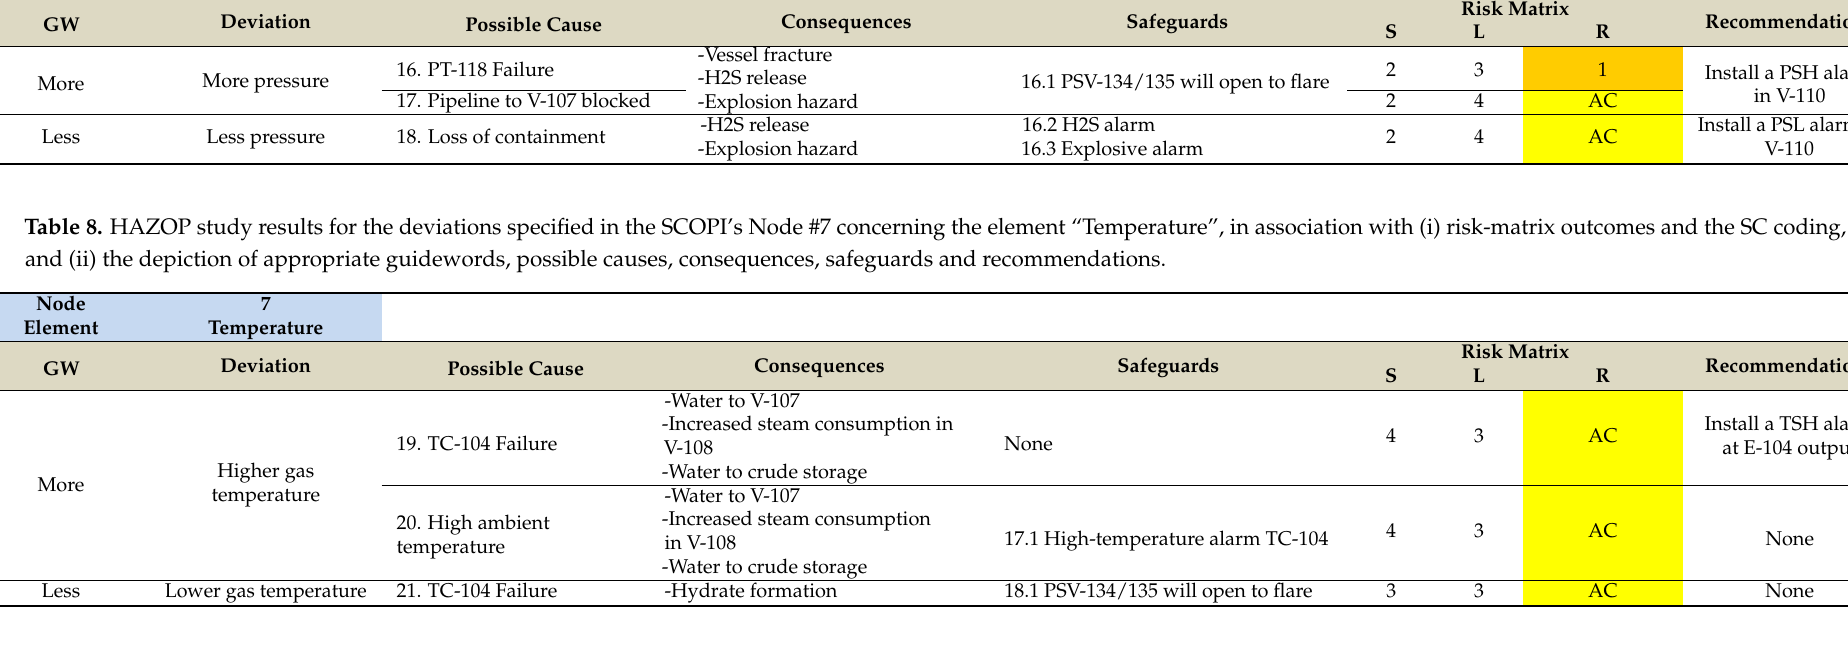
Table 9. HAZOP study results for the deviations specified in the SCOPI’s Node #7 concerning the element “Containment”, in association with (i) risk-matrix outcomes and the SC coding, and (ii) the depiction of appropriate guidewords, possible causes, consequences, safeguards and recommendations. Node